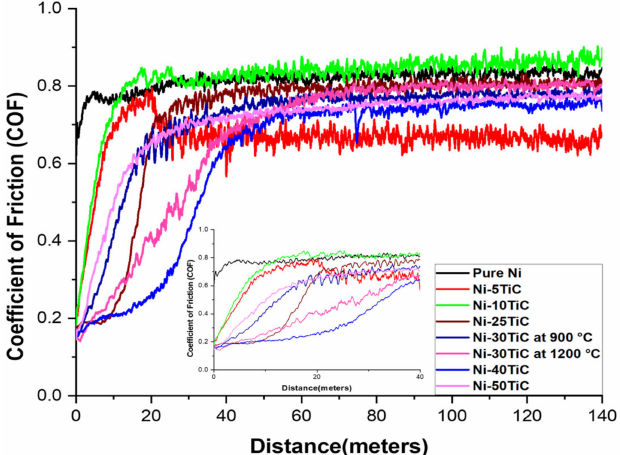
Figure 8. Coe ffi cient of Friction vs. 140 m